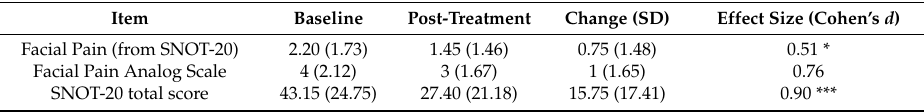
Table 2. Changes in facial pain from Young et al. [40]. All 20 patients reported baseline facial pain. Mean scores, SD, mean change in scores, effect sizes (Cohen’s d ) and published p -values are included.